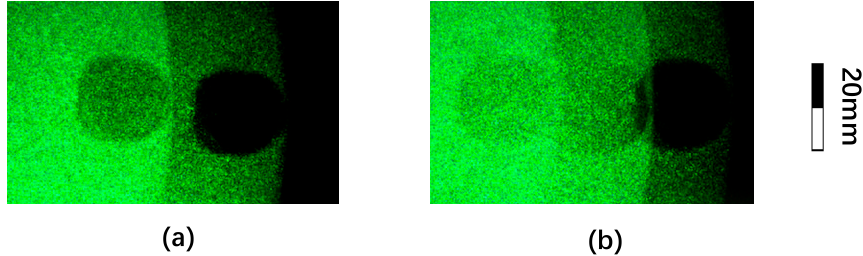
Figure 2. Images after shearing devices under 150-mW power laser illumination: ( a ) sheared by Rochon Prism (RP) and ( b ) sheared by Wollaston Prism (WP).